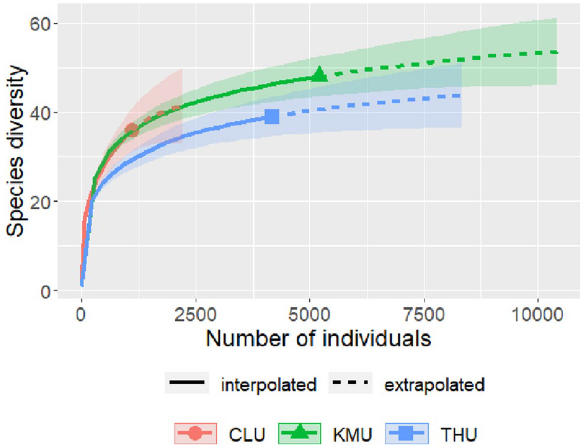
Figure 2. Sample coverage based rarefaction curve of dung beetles in less-, moderate-, and highly-urbanized landscape. The shaded areas indicate a 95% confidence